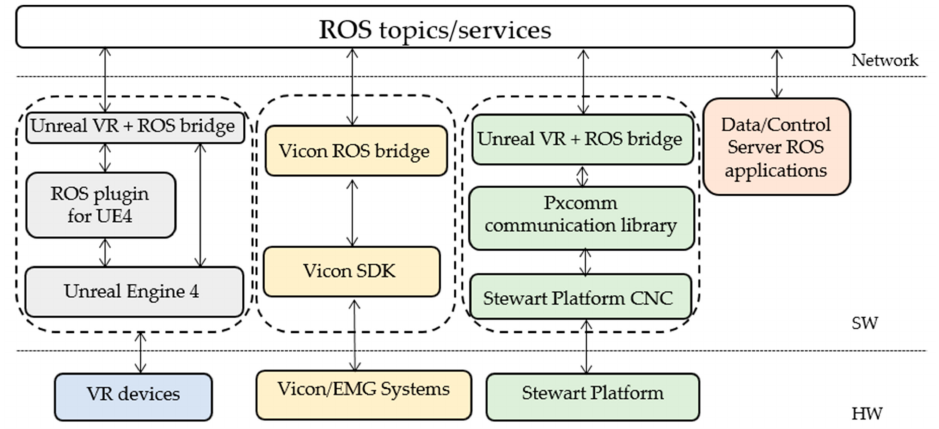
Figure 5. The software architecture of DORIS. The hardware (HW), software (SW) and network layers are sketched (separated by blue dashed lines). Each solid box represents a di ff erent subsystem or software layer. Each stack (dashed box) represents a di ff erent software module with its